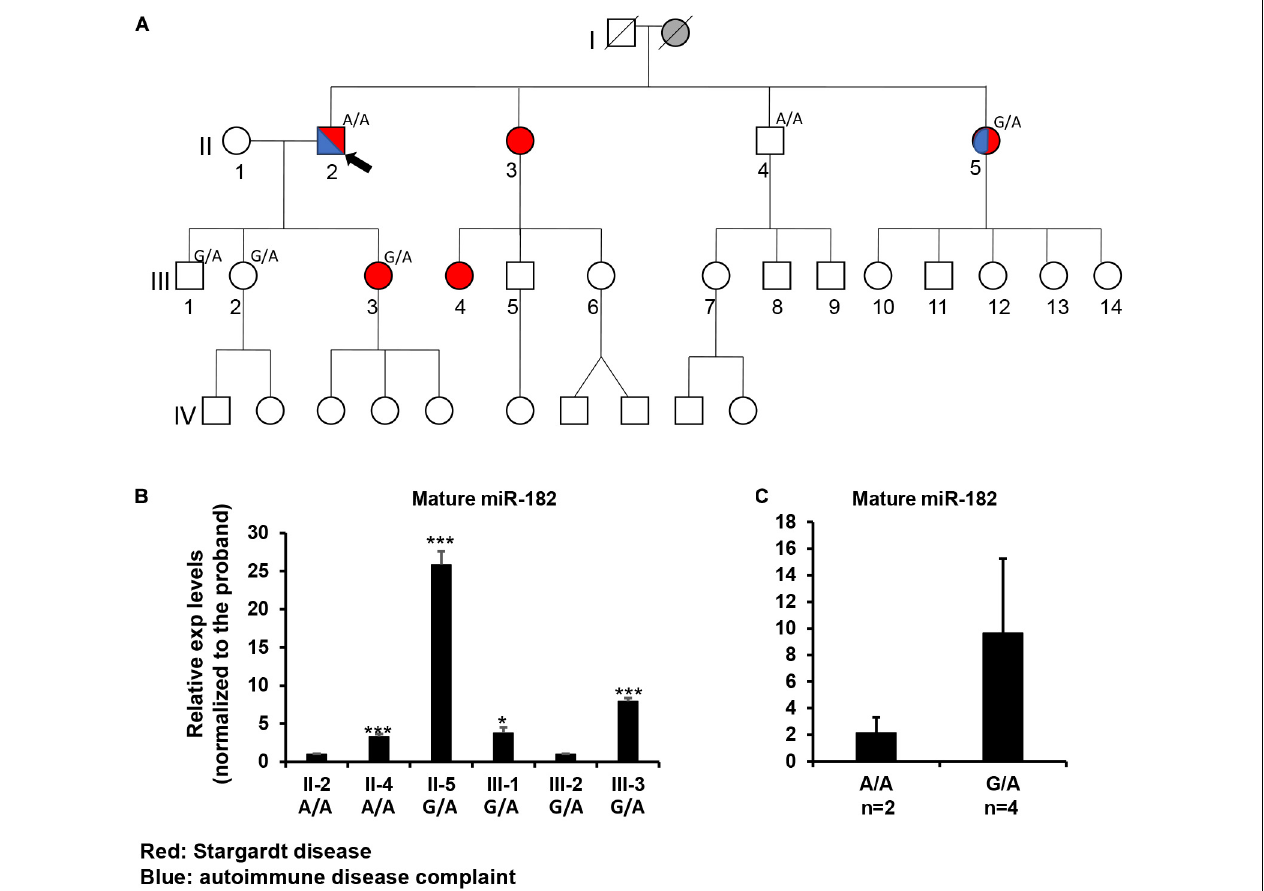
FIGURE 5 | Inheritance patterns of the pre-miR-182 nt106 G/A allele and the expression levels of mature miR-182 in peripheral blood mononuclear cells (PBMNC) in a family with multiple cases of Stargardt disease -Family 4100. (A) the family pedigree. Proband II-2 and his brother II-4 are homozygous for the less common pre-miR-182 nt106 A allele (A/A); while II-5, III-1, 2, 3 are heterozygous (G/A) for this allele. Red: with Stargardt disease. Blue: with Complaint of autoimmune disease(s). (B,C) qRT-PCR on pre-miR-182 in the PBMNC of selected family members. * p < 0.05; *** p <